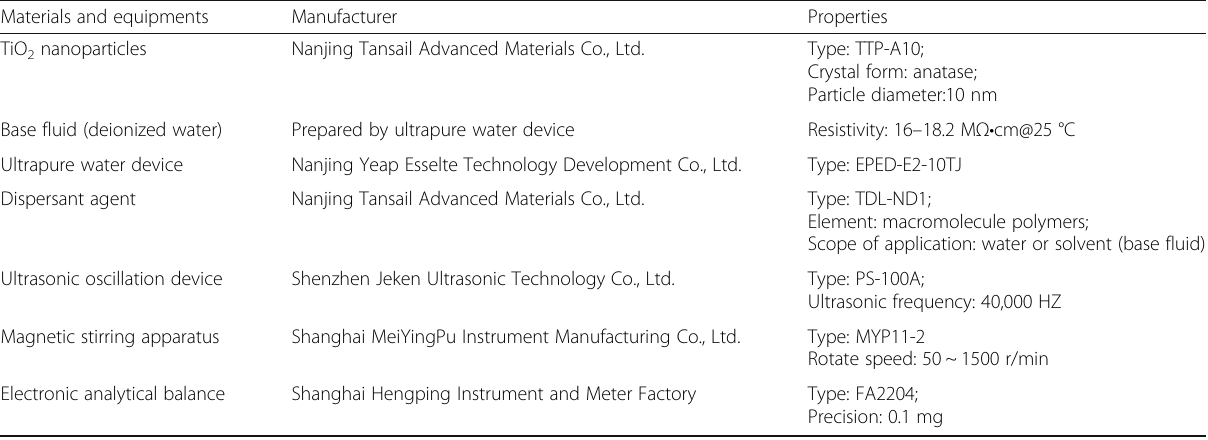
Table 1 Information of materials and equipments. Information of some materials and equipments in the preparation of nanofluids Materials and